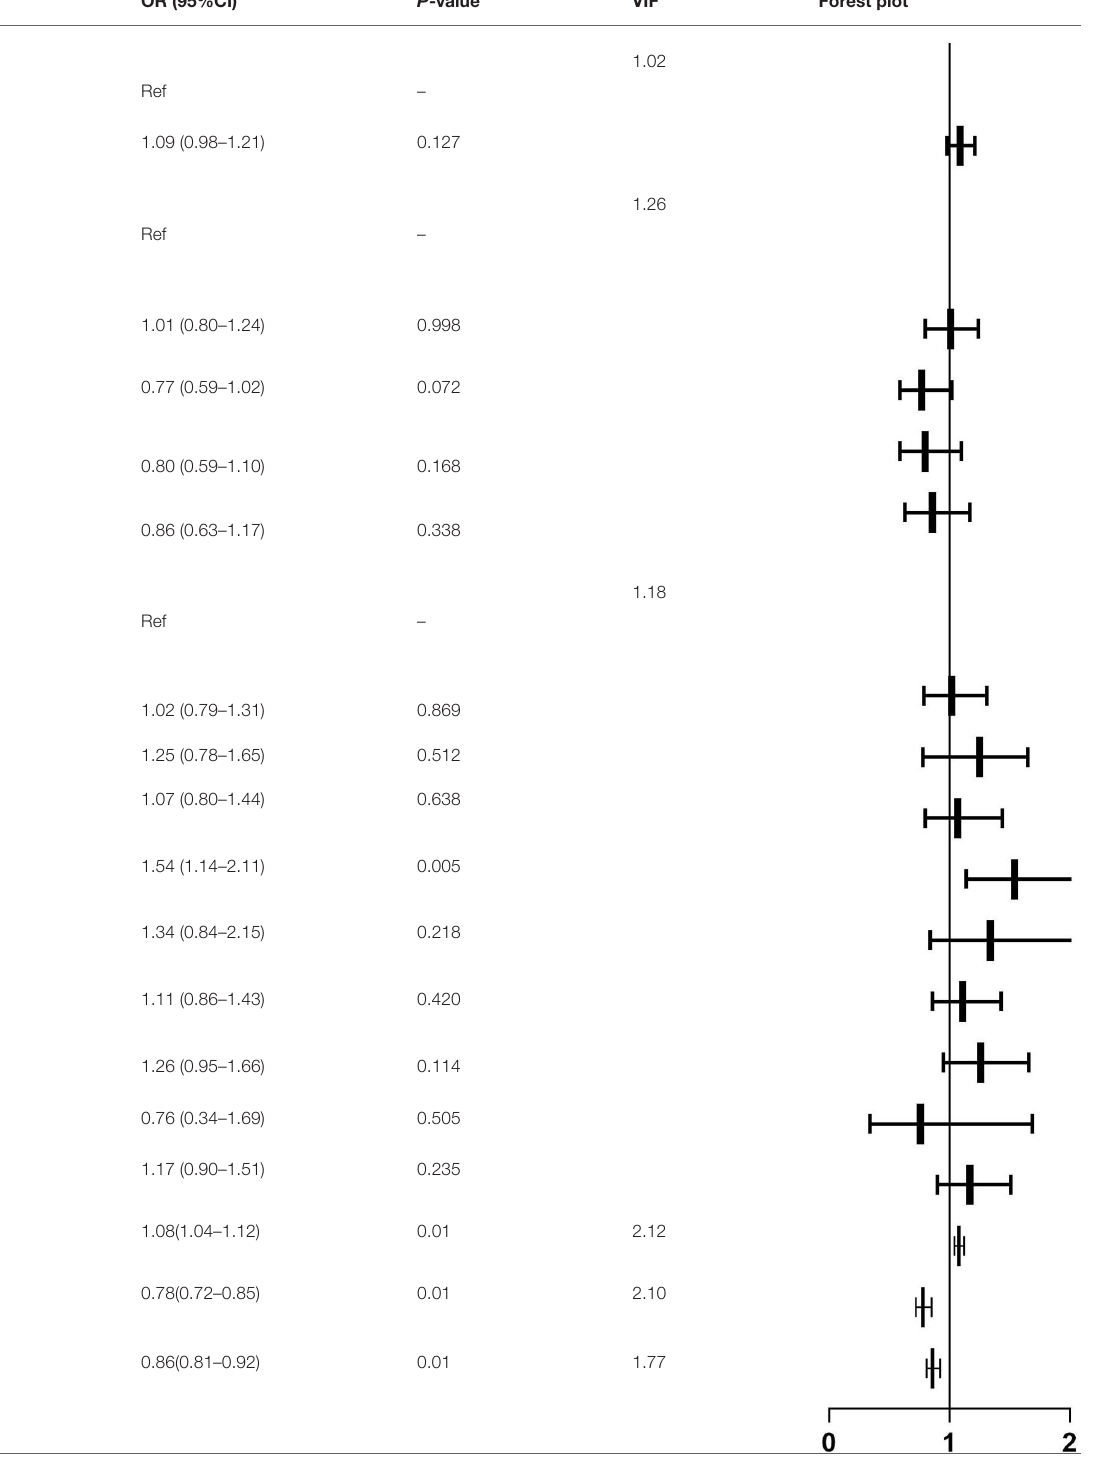
TABLE 3 | The odds ratio with the number of common cold and presented in the forest plot. Variables OR (95%CI) P -value VIF Forest